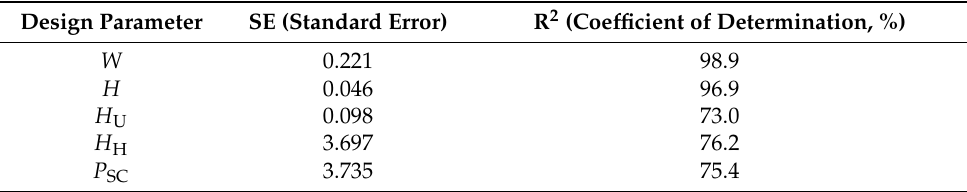
Figure 10. Comparison between measured and predicted welding parameters: ( a ) Top-Bead width, ( b ) Top-Bead height, ( c ) Hardness of upper part, ( d ) Hardness of HAZ, and ( e ) Crack susceptibility. Table 11. Results of verification of the predicted model.